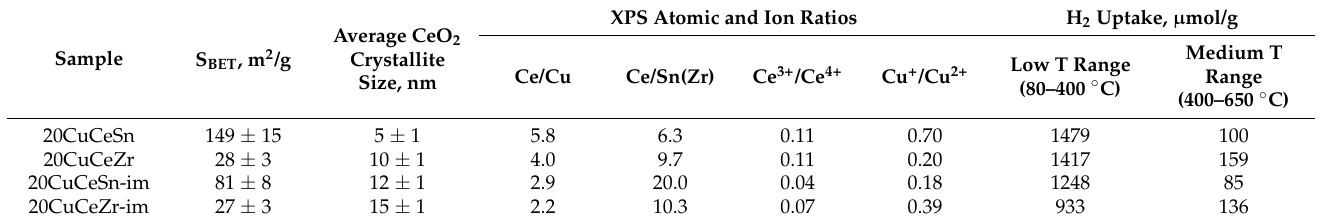
Table 1. Physicochemical parameters of 20CuCeSn and 20CuCeZr catalysts prepared by the one-pot and wet impregnation methods.